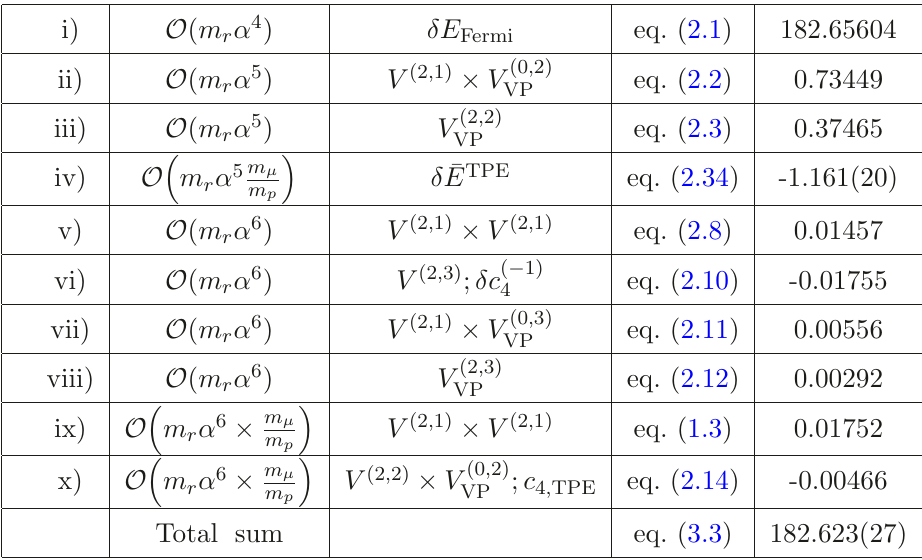
Table 1 . The different contributions to the hyperfine splitting for the 1S in muonic hydrogen in meV units. The value for the iv) and x) entries is obtained from the hydrogen hyperfine